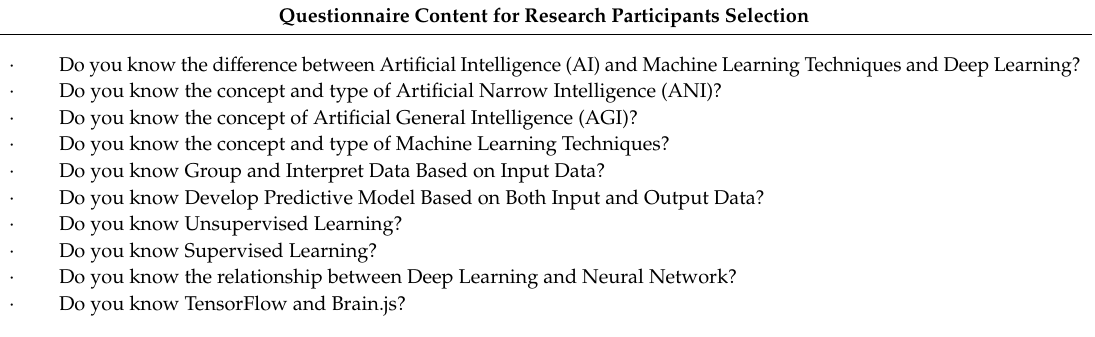
Table 5. Research Instrument for Selecting Research Participants.